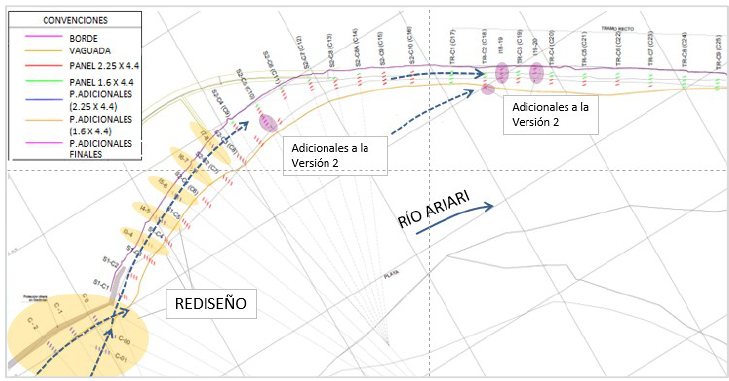
Figure 28. Ariari River, PR68: vane field installed according to version 2 of the redesign and additional vanes.